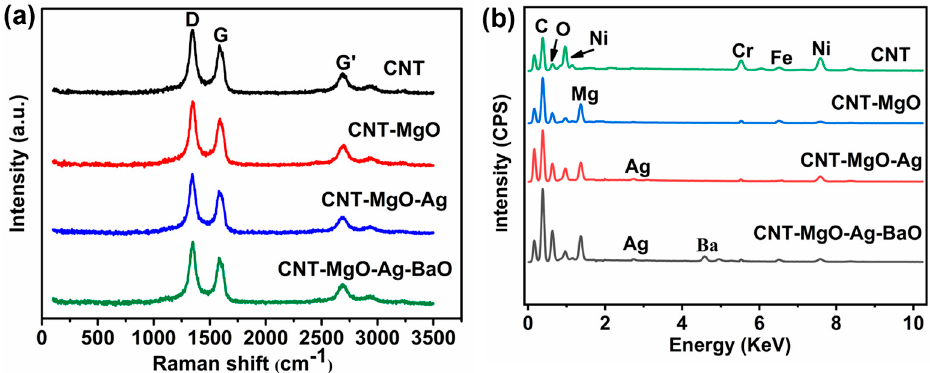
Figure 2. ( a ) Raman and ( b ) EDS results of the pristine CNTs and CNT-based nanocomposites.